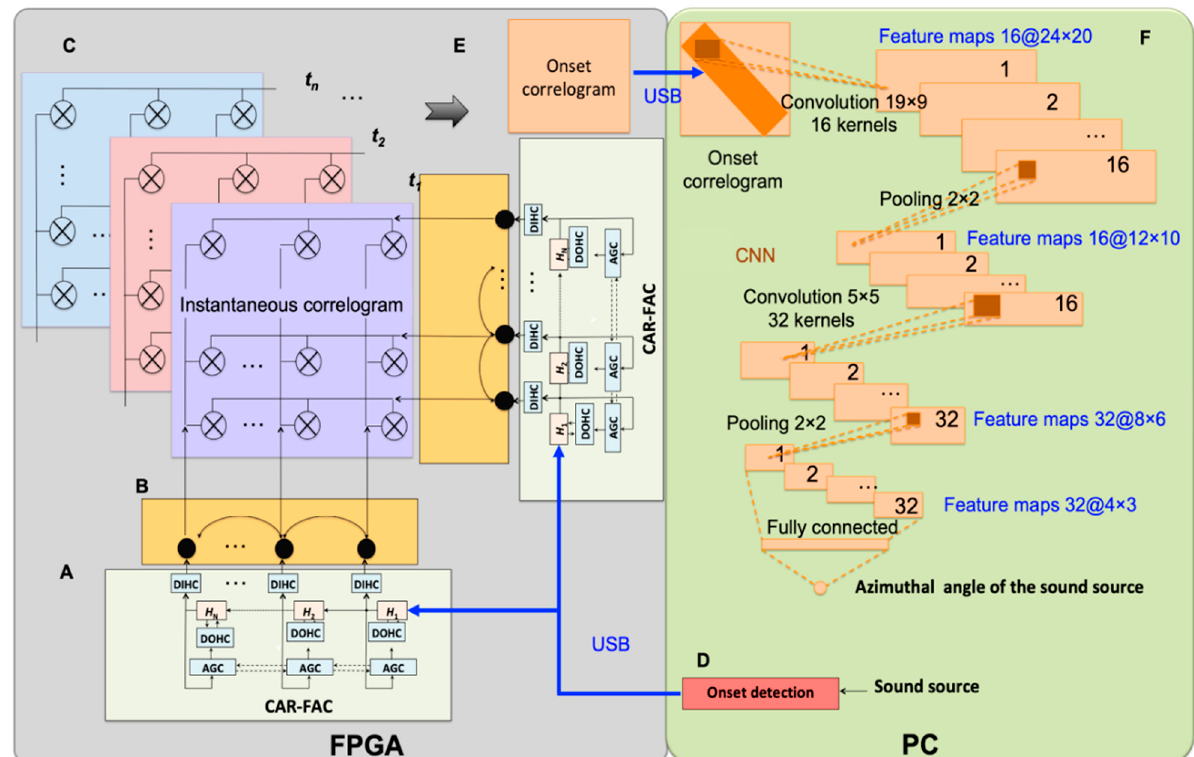
Figure 1. Architecture of the binaural sound localisation system. ( A ) The Cascade of Asymmetric Resonators with Fast- Acting Compression (CAR-FAC) model, H 1 to H N are the transfer functions of the CAR part, the centre frequencies (CFs) of the resonators decrease from H 1 to H N . The digital outer hair cell (DOHC), the digital inner hair cell (DIHC), and the automatic gain control (AGC) comprise the FAC part. The DIHC output is connected to the lateral inhibition (LI) function. ( B ) The LI unit; ( C ) The instantaneous correlogram: the circle marked with a cross is an instantaneous correlation unit, and the output from all the units forms a 2-D correlogram. ( D ) The onset detection function; ( E ) The onset correlogram; a short period after the onset detection, 𝒕 𝟏 to 𝒕 𝒏 , includes n instantaneous correlograms. The n instantaneous correlograms are averaged to form the onset correlogram. ( F ) The regression convolutional neural network (CNN); the onset correlogram is used to train the CNN to learn the azimuthal angle of the sound source. The details of the CNN will be described later in the Experiments and Evaluation section. In this system, the binaural CAR FAC and the onset correlogram have been implemented on Field Programmable Gate Array (FPGA), and the onset detection and the CNN were implemented on a PC, but can also be ported to FPGA.